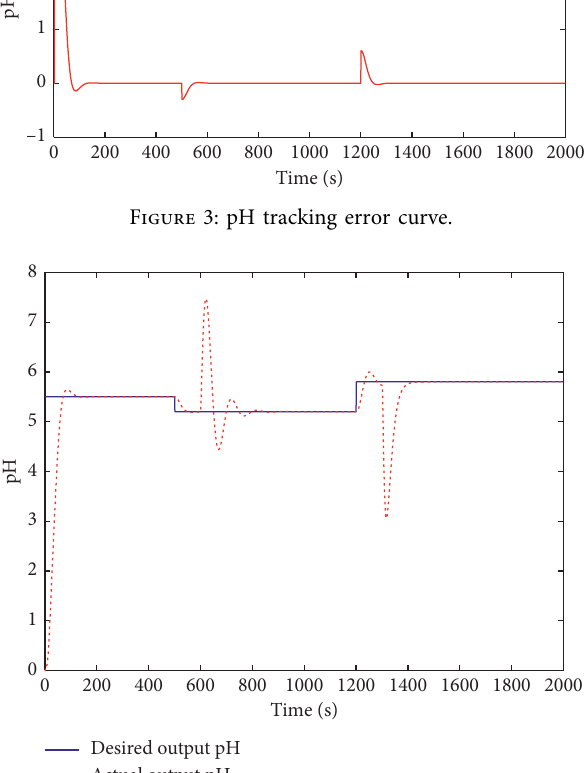
Figure 4: pH tracking